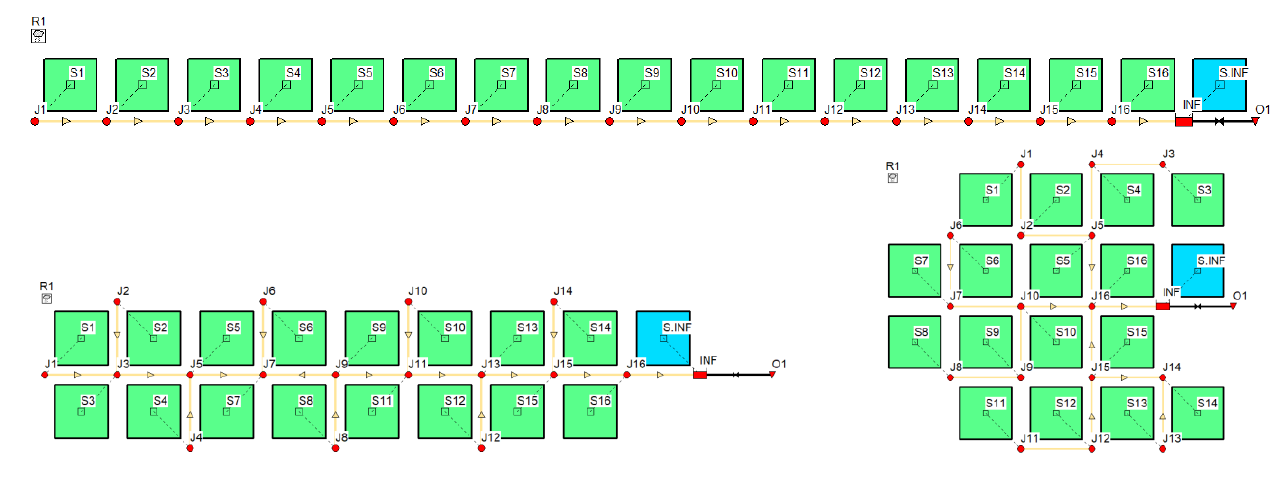
Figure 3. The analyzed catchments, consisting of sixteen subcatchments (J1 – J16 — junctions; S1 – Figure 3. S16 — subcatchments; S.INF — subcatchment simulating rainfall over an infiltration facility; INF — infiltration facility; R1 — rain gage; O1 — outlet from the overflow).